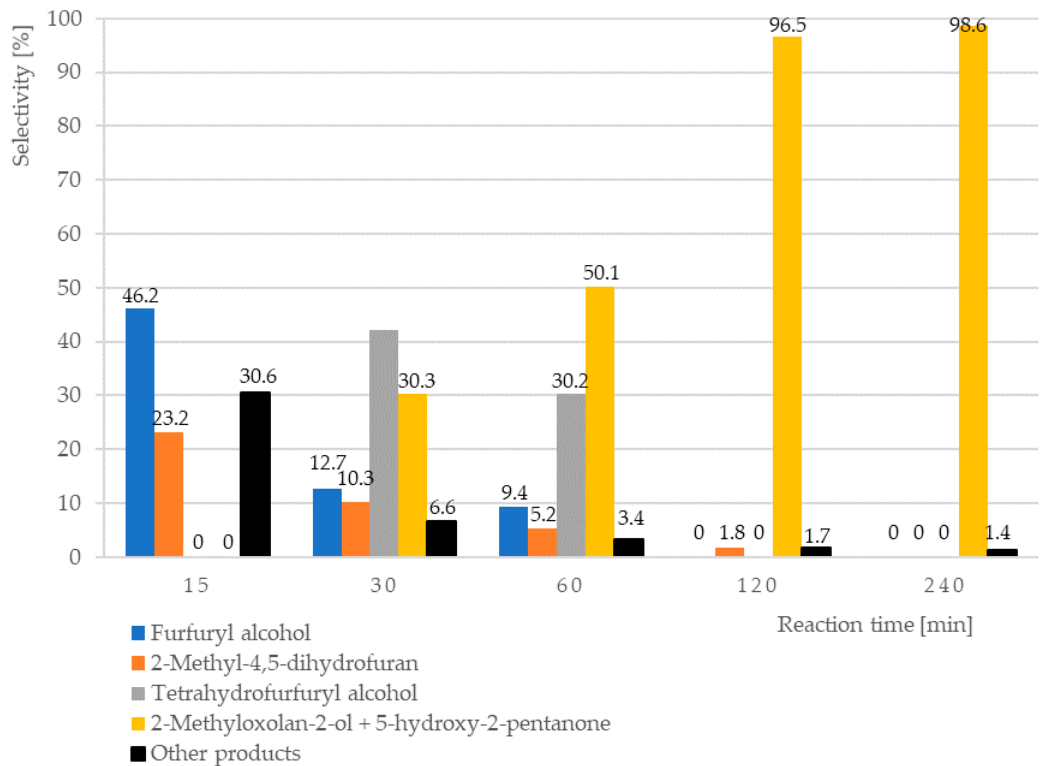
Figure 1. The influence of reaction time on selectivity into invidual products (furfuryl alcohol, 2-methyl- 4,5-dihydrofuran, tetrahydrofurfuryl alcohol, and 2-methyloxolan-2-ol + 5-hydroxy-2-pentanone) of the furfural reduction in water over 5%Pd-1%Au / SiO 2 catalyst. Reaction conditions: T = 90 ◦ C, p H2 = 20 bar, m cat = 0.5 g, C 0 Furfural = 0.1 M, V Furfural = 25 mL; Catalysts after drying in air at 110 ◦ C, 6 h were reduced in H 2 at 300 ◦ C, 2 h .